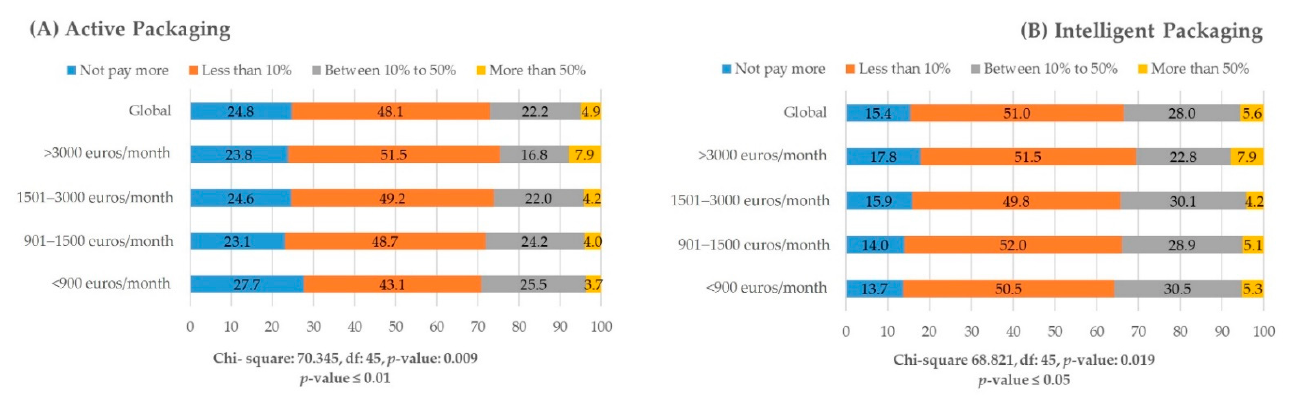
Figure 8. Willingness to pay more. ( A ) For active packaging; ( B ) For intelligent